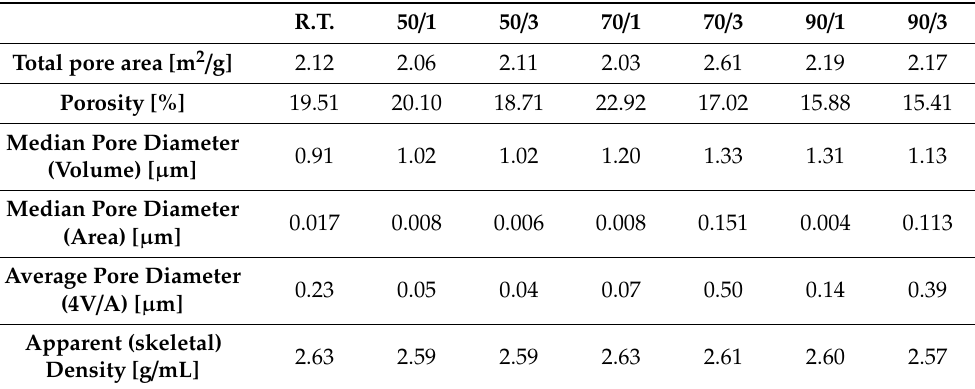
Table 4. The values of di ff erential MIP